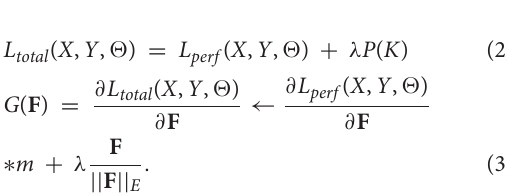
height ˆ H i and width ˆ W i of tensor X i ) in a balanced way.